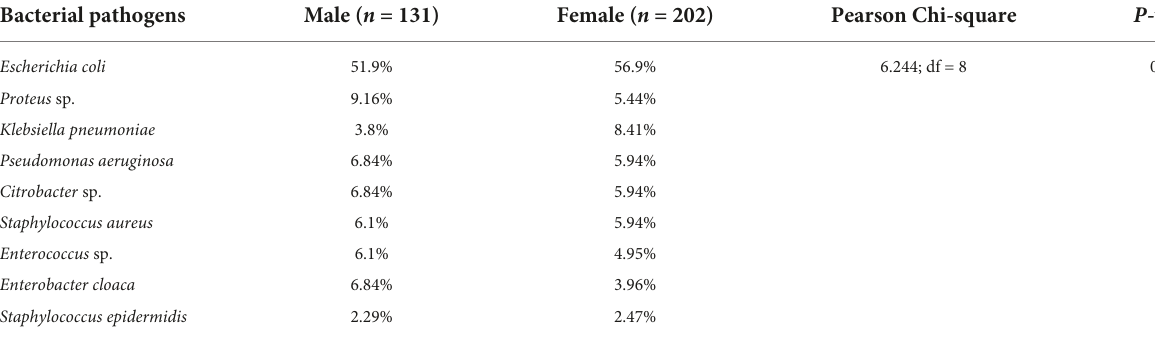
TABLE 2 Distribution of bacteria among gender in the study population. Bacterial pathogens Male ( n = 131) Pearson Chi-square